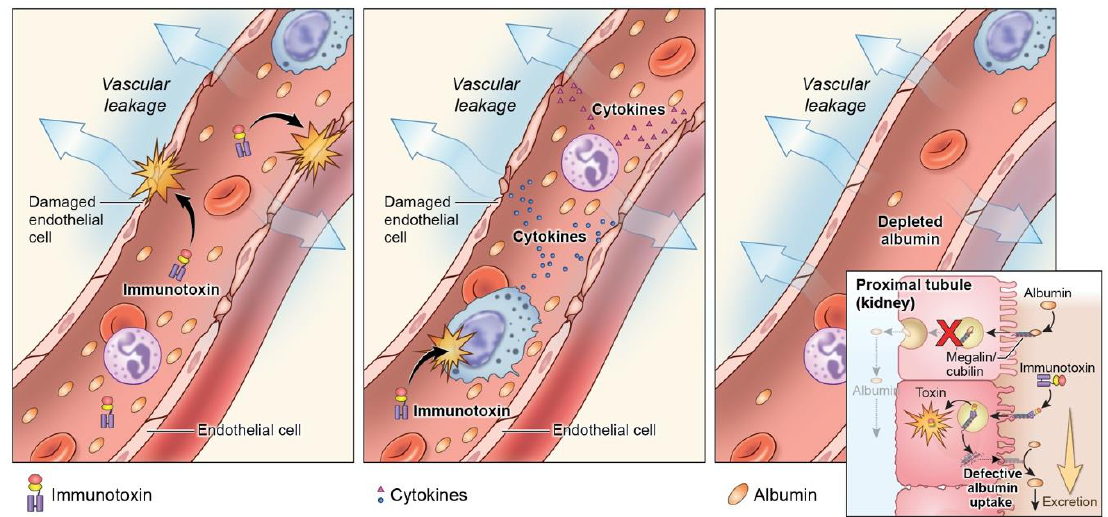
Figure 3. Proposed mechanisms of capillary leak syndrome (CLS). The left panel shows direct damage to endothelial cells by iTox. An alternate theory is that stimulation of immune cells by iTox induces release of a circulating factor which causes endothelial damage and CLS (middle panel). The right panel illustrates the hypothesis that iTox-induced loss of albumin in the proximal convoluted tubule of the kidney leads to hypoalbuminemia and CLS results from decreased osmotic pressure and / or compensatory renal signaling